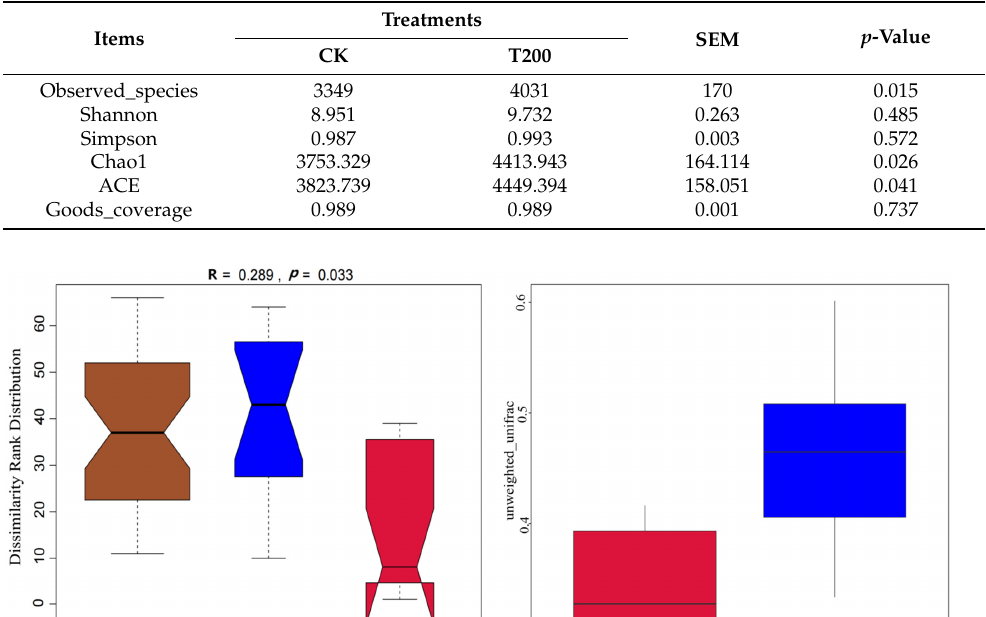
Table 1. Alpha diversity analysis of bacterial communities in rhizosphere soil.